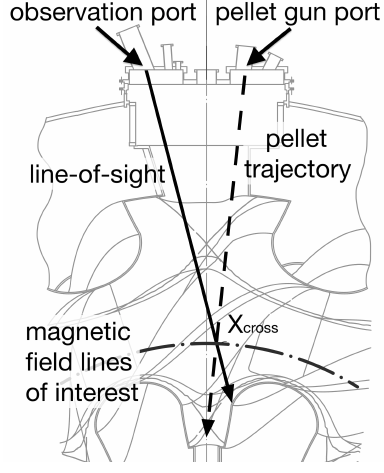
Figure 1. Toroidal section schematic where fuel pellet injection experiment is conducted in LHD. The magnetic field lines of interest marked by the dash-dotted line are located near the major radius of interest R cross ∼ 3.6 m. The line-of-sight of the observation device shown by the solid line and the trajectory of the ablating pellet meet at X cross , where X cross corresponds to a location where the line-of-sight and the magnetic field lines of interest are almost perpendicular. It is necessary to target this location because the ablation clouds are roughly elongated following the direction of the magnetic field lines they are on. This perpendicularity improves the resolution power of the observation system the line-of-sight. Ablating pellets are also expected to emit enough photons for measurement purposes when they reach X cross